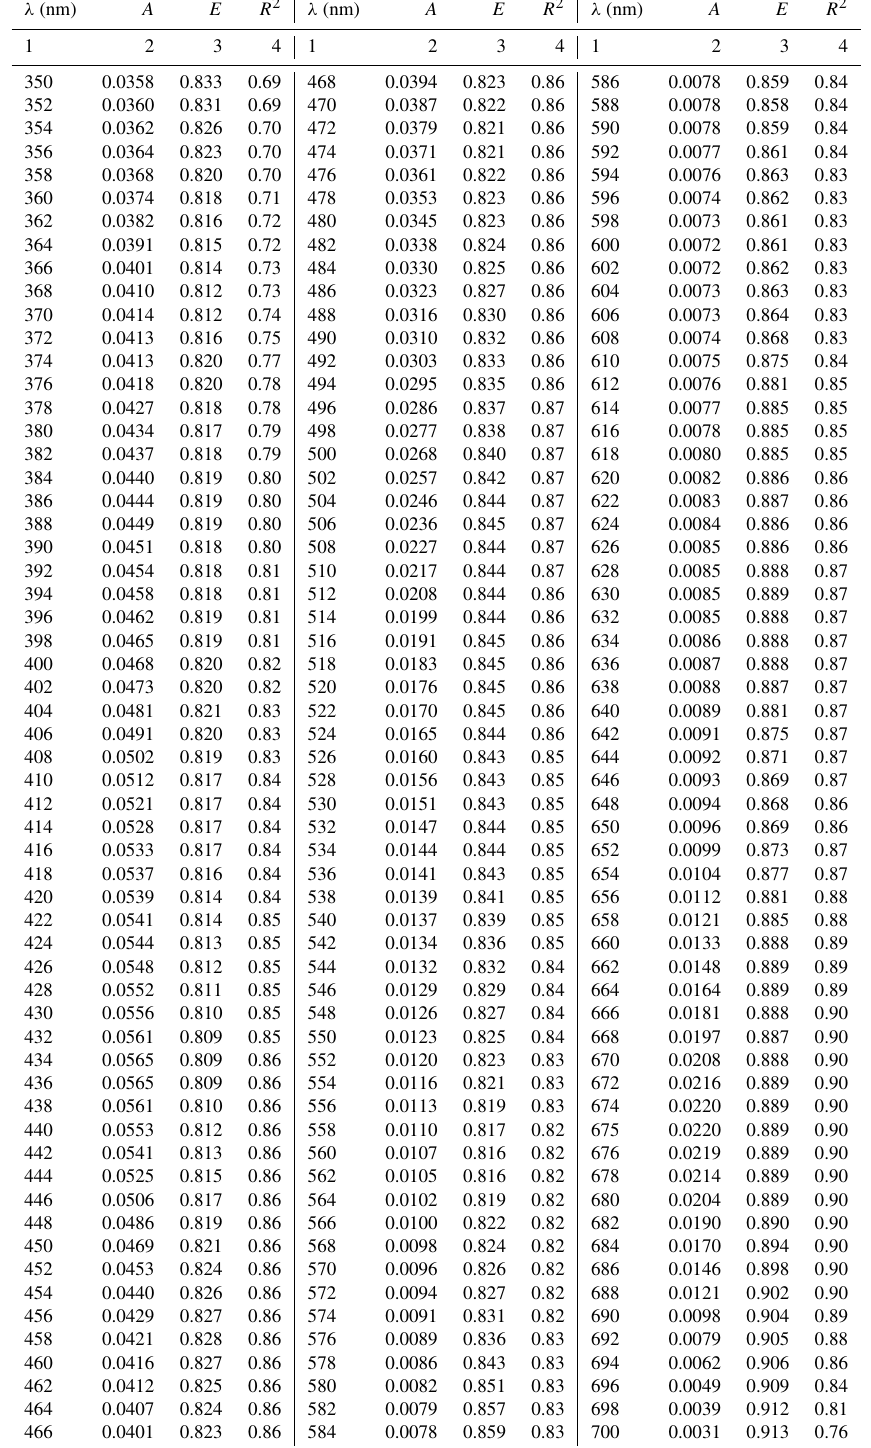
Table A1. Spectral coefficients A and E of the one-component parameterization described by Eq. (3a) in its general variant (i.e. the variant obtained when all data, regardless of the month of acquisition, were taken into account) and the corresponding determination coefficients R 2